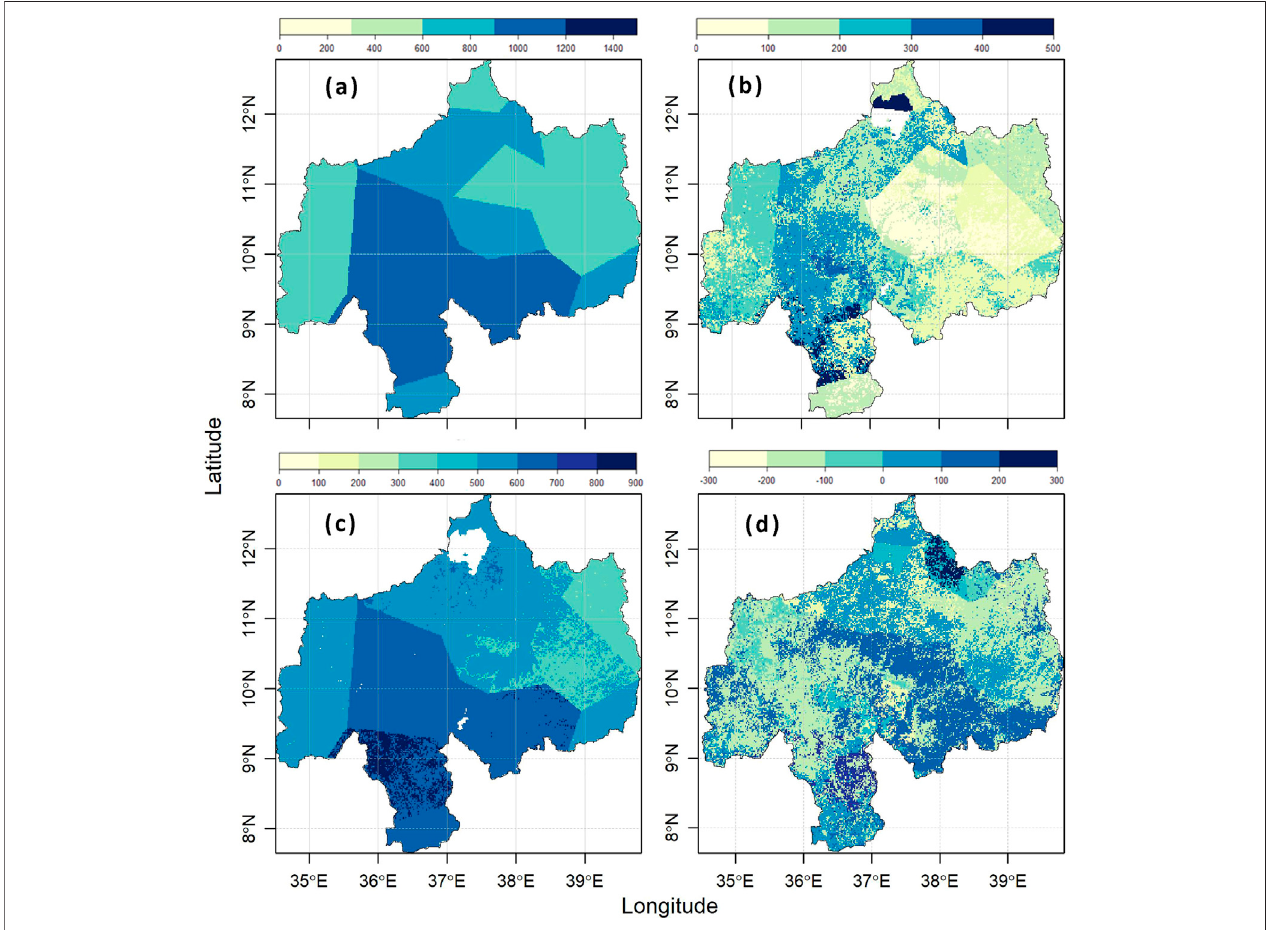
FIGURE 6 | The spatial distributions of long-term mean annual water budget components: precipitation (A) , runoff (B) , ET (C) and TWSC (D) . All units are in mm.